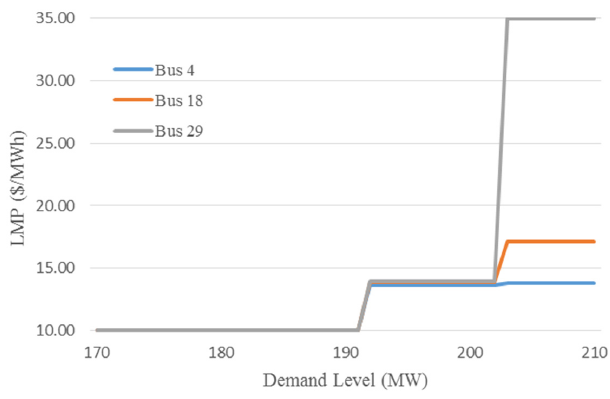
Figure 7. Bus LMPs in IEEE 30 ‐ bus system with different demand level.